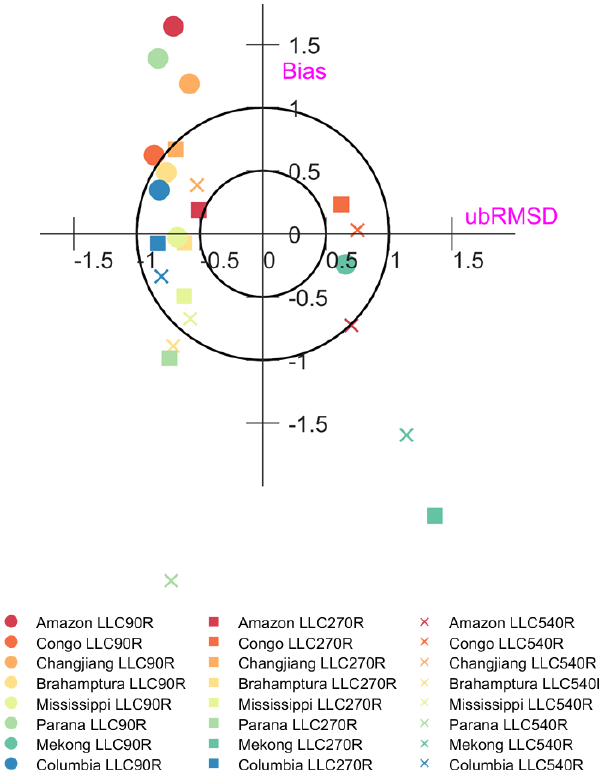
Figure 5. Same as Fig. 4, but for LLC90R, LLC270R, and